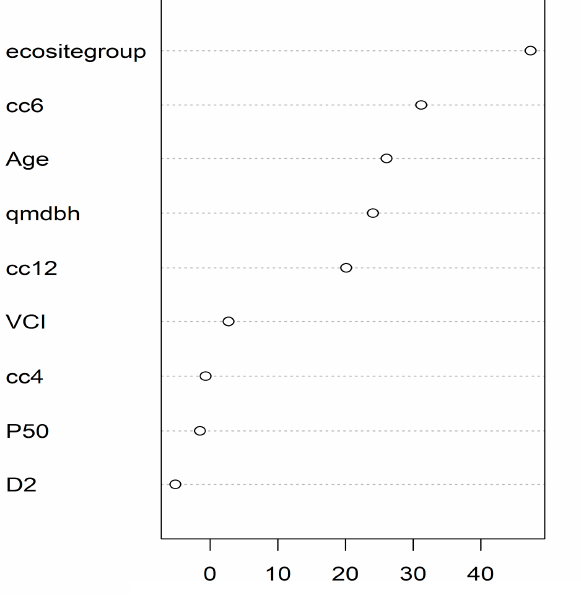
Figure 8. Regression tree analysis of mean wood density (kg·m − 3 ) of black spruce increment core samples collected between 2011 and 2014 from the Hearst Forest management unit in Northeastern Ontario (n = 109). The top figure illustrates the decision tree derived from the analysis, the boxplots illustrate the range of predicted values within the nodes of the tree. Predictors included ALS structural variables canopy closure at 6 and 12 m (cc12 and cc6), Quadratic mean diameter at breast height (QMDBH), vertical complexity index (VCI), and FRI-derived ecosite classifications (a = Fresh sandy and dry to fresh coarse loamy, b = moist sandy to coarse loamy, c = fresh clayey, d = fresh silty to fine loamy, e = intermediate conifer swamp, f = poor conifer swamp) and age derived directly from core samples.